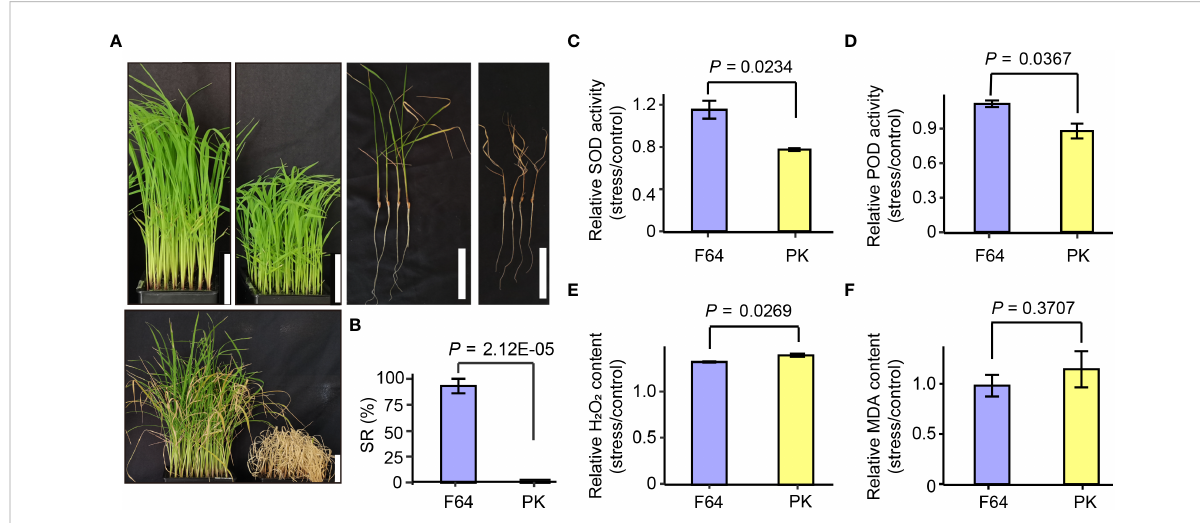
FIGURE 2 The differences in morphological and physiological performances between two rice accessions differing in their tolerance to heat stress. (A) Growth images of the heat-tolerant accession FACAGRO 64 (F64) and the heat-sensitive accession PUILLIPINA KATARI (PK) before and after heat stress treatment. Scale bars = 5 cm. (B) SR of the two rice accessions in 7 d after heat stress. Data are extracted from Supplementary Table S1. (C – F) The relative SOD, POD, H 2 O 2 and MDA content between heat stress for 72 h and control conditions. Data shown in the form mean ± standard deviation of three biological replicates. The signi fi cant difference between the two groups was calculated using two-tailed Student ’ s t -